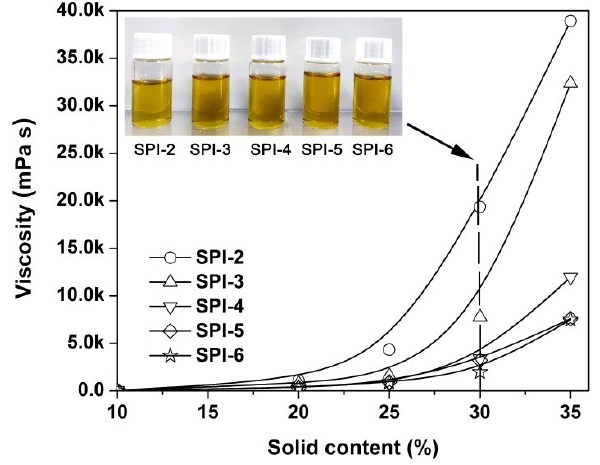
Figure 4. Relationship between the solid contents and the absolute viscosities of the SPI solutions. (Insert: appearance of the SPI solutions).